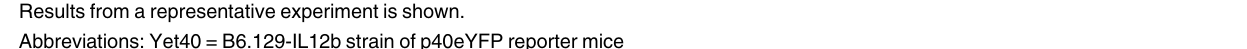
Table 1. Experimental autoimmune encephalitis induced by active immunization. Group Incidence Mean Maximum Score Mean (SD) C57BL/6 Yet40 Results from a representative experiment is